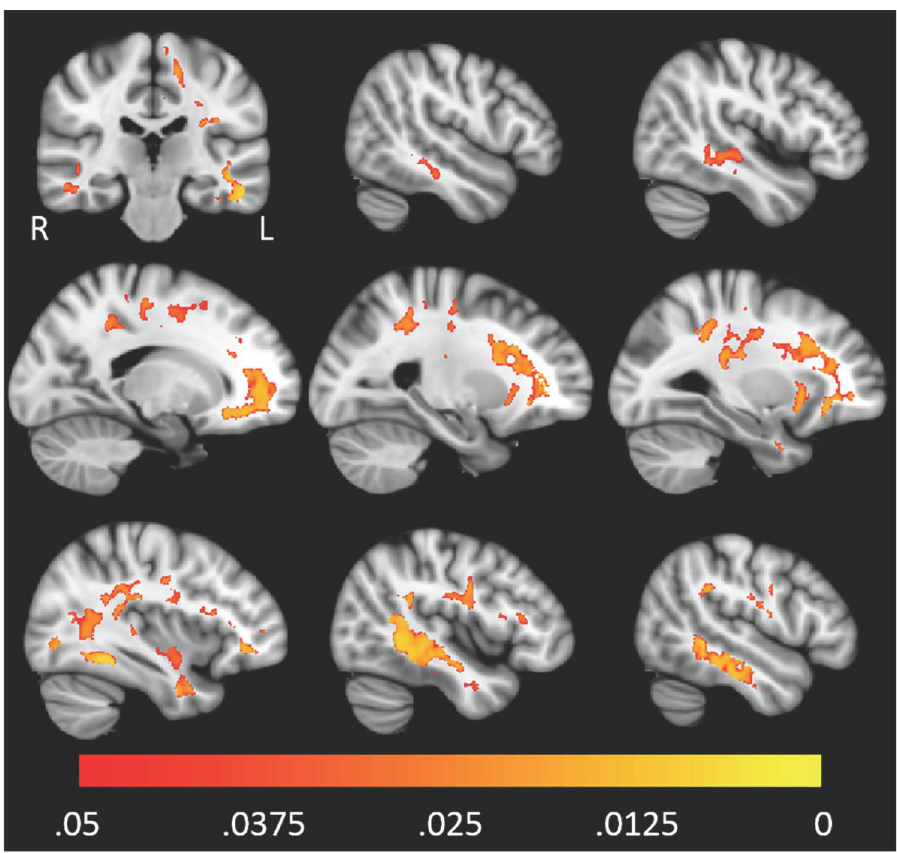
Fig 3. Higher levels of pTau 181 /A β 42were associatedwith higher FWE-DTI f -value throughout white matter. The red-yellowcolor scale above shows the familywise error corrected P-value. The underlayimage is a T1w MNI template with 1 mm